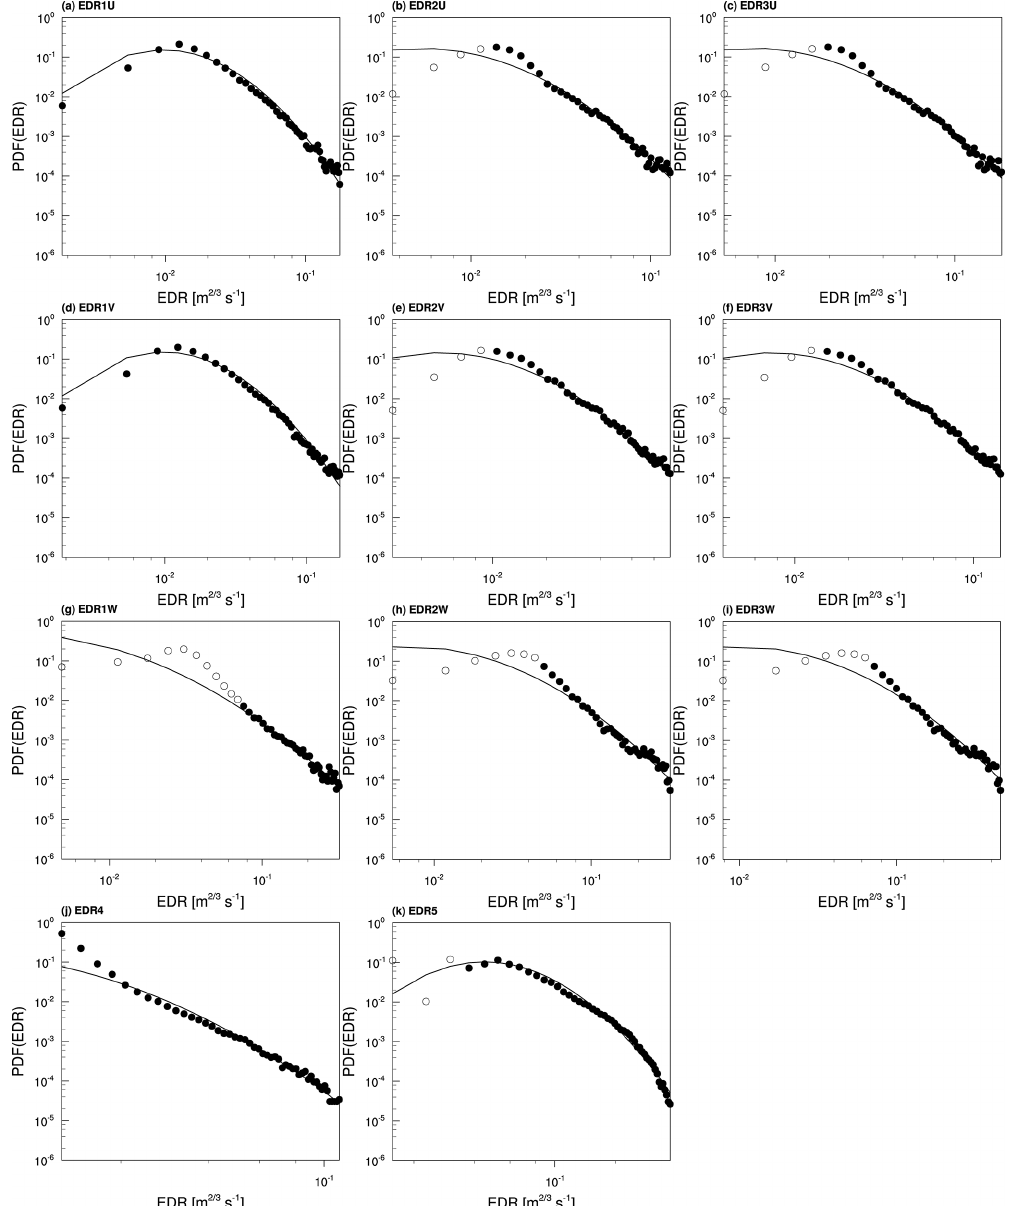
Figure 8. The PDFs (circle) of the EDRs and lognormal fit (continuous line) over the EDRs obtained from the B737 data. The filled circles indicate data that were used in the fit, and the open circles indicate data that are excluded from the fit. It is noted that the different range of x axis is used in each